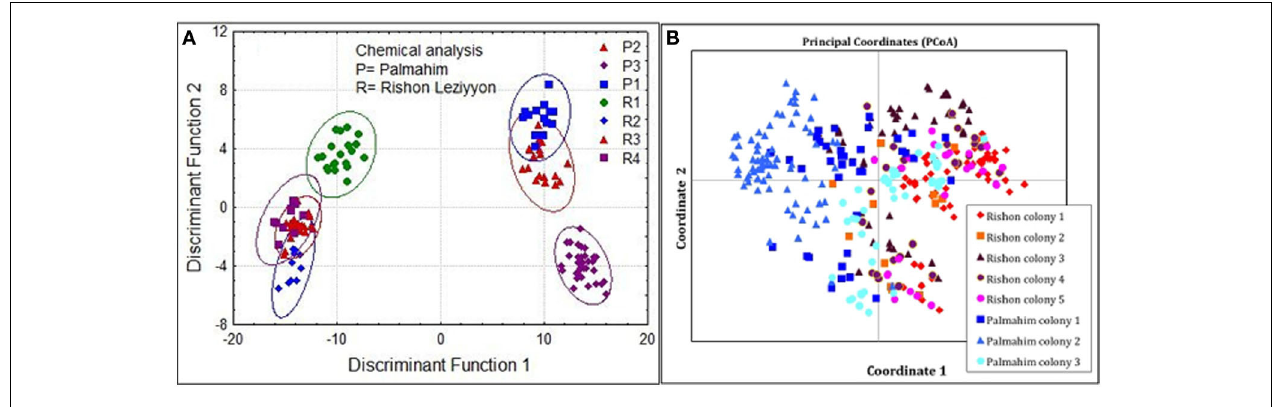
FIGURE 5 | Chemical and genetic comparisons between colonies comprising the two populations studied, Palmahim and Rishon Leziyyon. Discriminant analysis of cuticular hydrocarbons (A) and Principal Coordinates Analysis (PCoA) based on the microsatellite